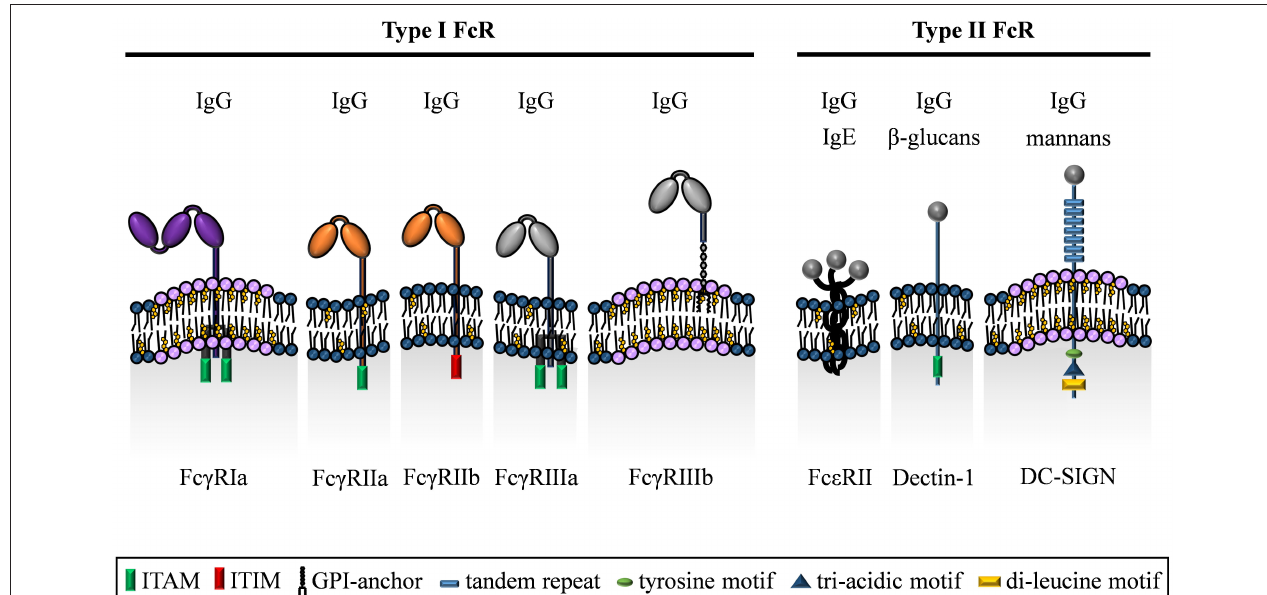
FIGURE 2 | The family of IgG binding type I and type II Fc receptors. The Fc receptors for IgG can be distinguished by their distinct binding mechanisms into either type I FcRs (classical Fc γ R) or type II FcRs (C-type lectin receptors). With respect to signal transduction, Fc γ RIa, Fc γ RIIa, Fc γ RIIIa, and Dectin-1 signal via ITAM domains in their cytoplasmic tail or on the associated Fc ε R γ chain. In contrast, the only inhibitory receptor Fc γ RIIb carries an ITIM domain in its cytoplasmic region. In addition, the GPI-linked Fc γ RIIIb lacks an intracellular signaling domain, but has a crucial role in binding of IgG immune complexes and enhances signaling upon cross-linking with other Fc γ Rs. Besides, Fc ε RII has a short cytoplasmic region, whereas DC-SIGN exhibits a cytoplasmic domain including tyrosine, di-leucine and tri-acidic motifs. In addition to recognizing IgG, Dectin-1 and DC-SIGN are known to bind other ligands including defined sugar